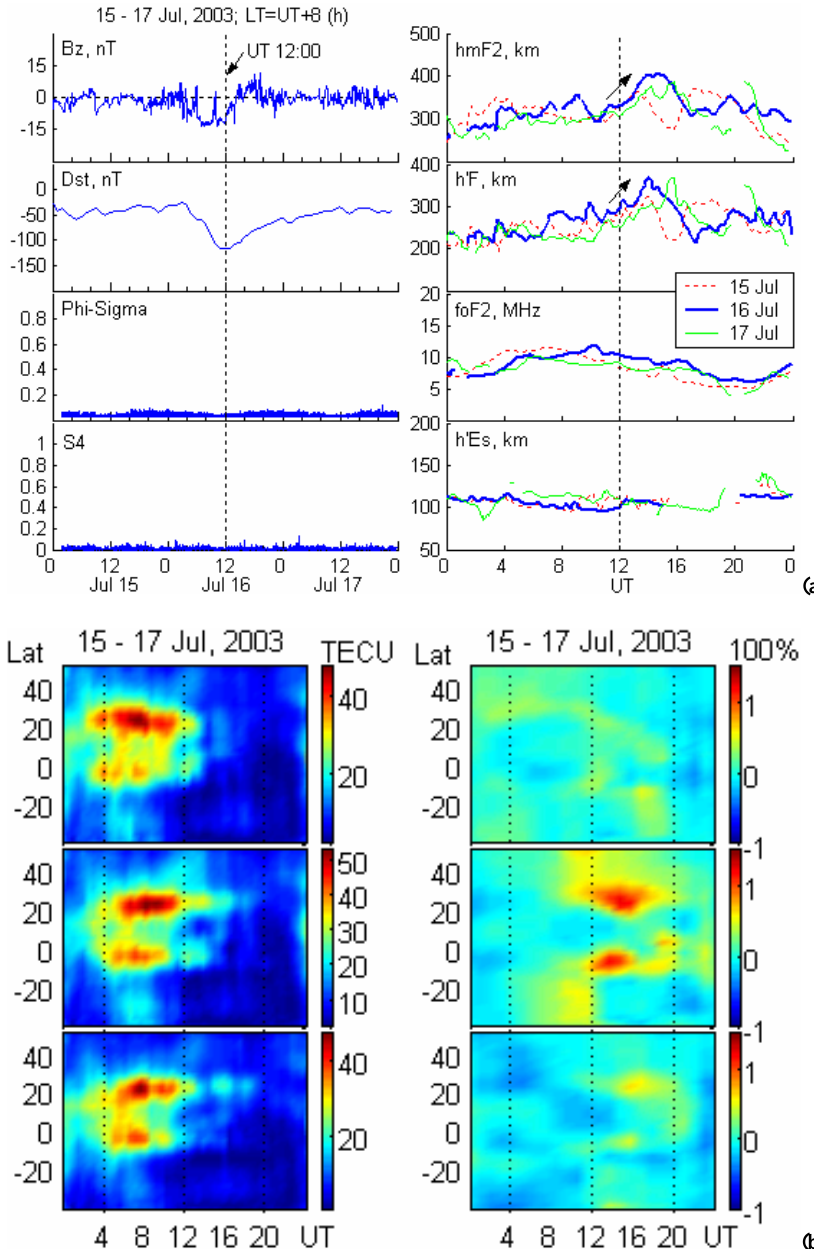
Fig. 4. (a) B z component of IMF, D st index, Phi-Sigma and S4 index; hm F2, h 0 F, fo F2 and h 0 Es for the period 15–17 July, 2003. (b) Latitudinal variation of TEC (left) and RTEC (right) along geographic longitude 110 ◦ E for 15 July (top panel), 16 July (middle panel) and 17 July (bottom panel), 2003, show the EIA development.